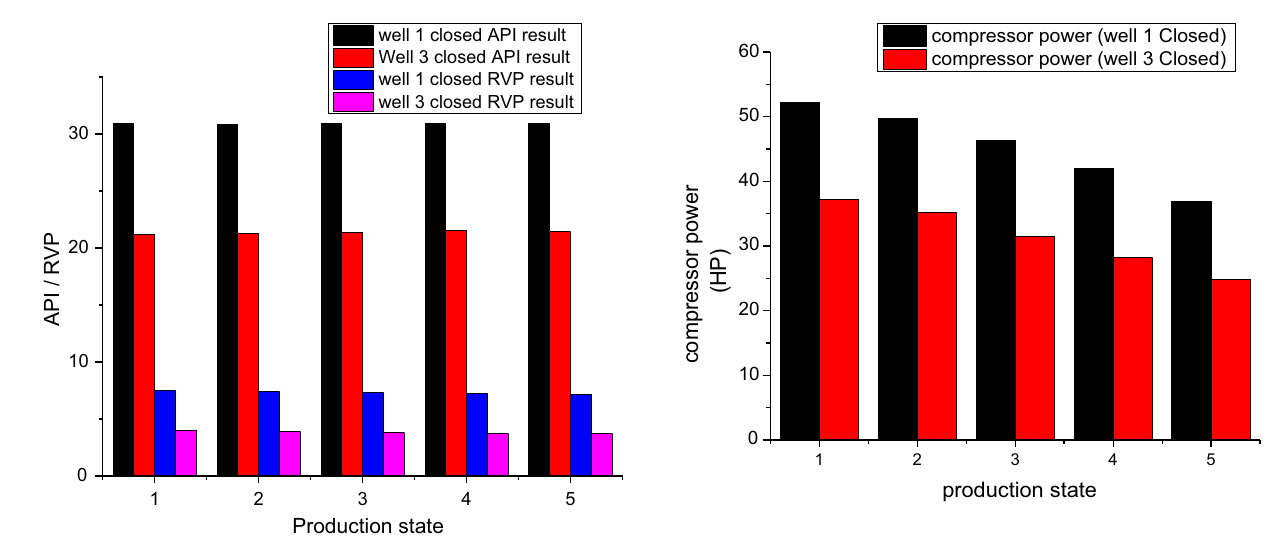
Fig. 11 Compressor power versus various production